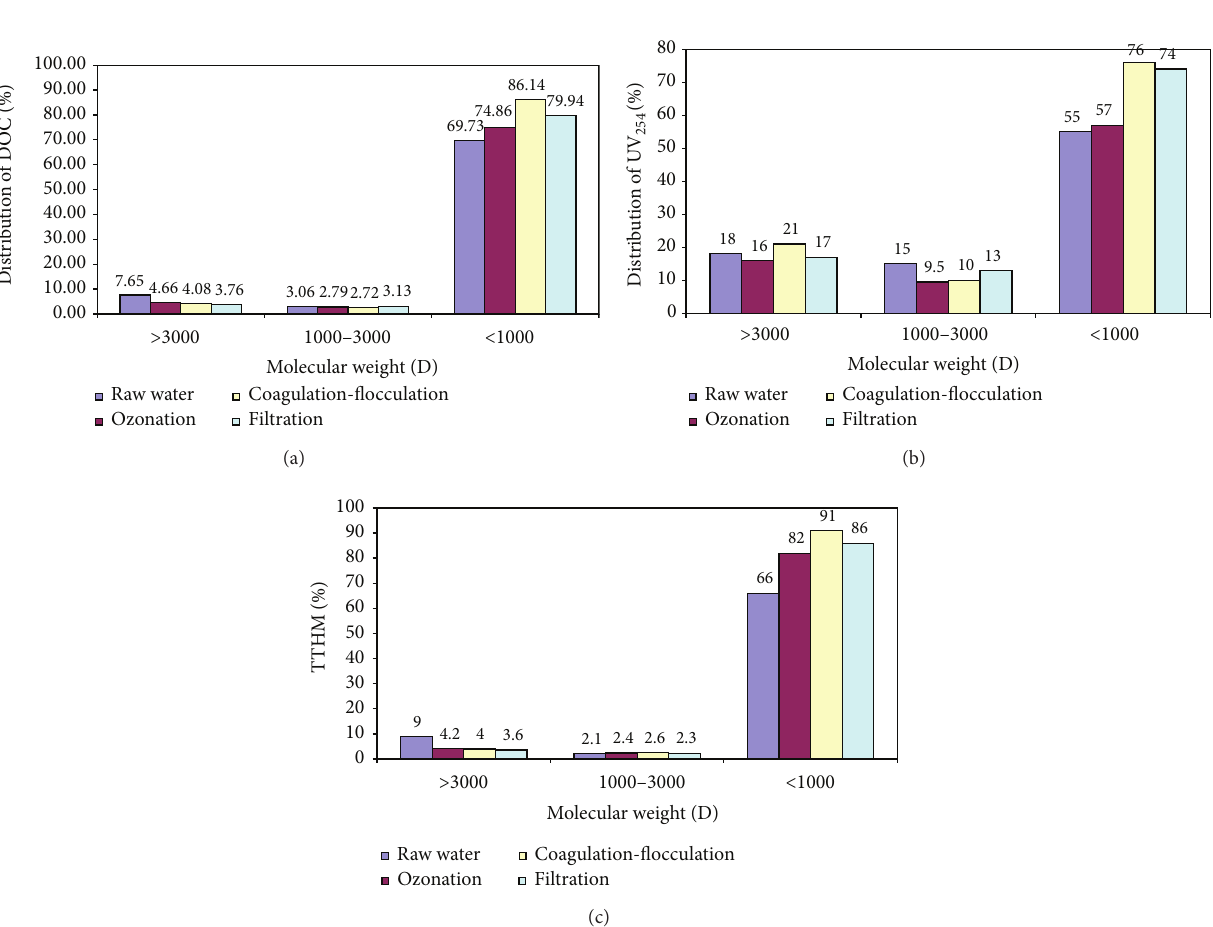
parameter for representing the aromatic carbon content